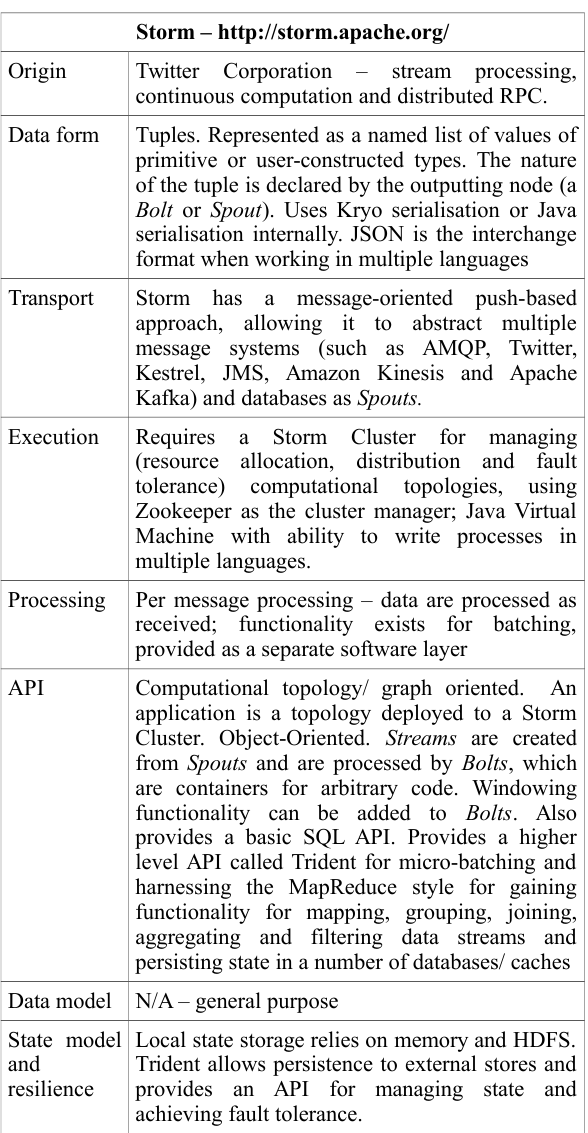
Table 3: Streaming Frameworks - Kafka